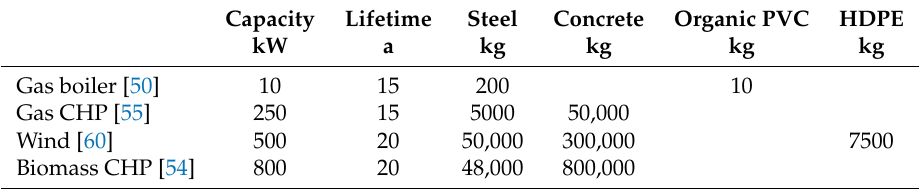
Table A3. Capacity, lifetime and material data for conversion units—part